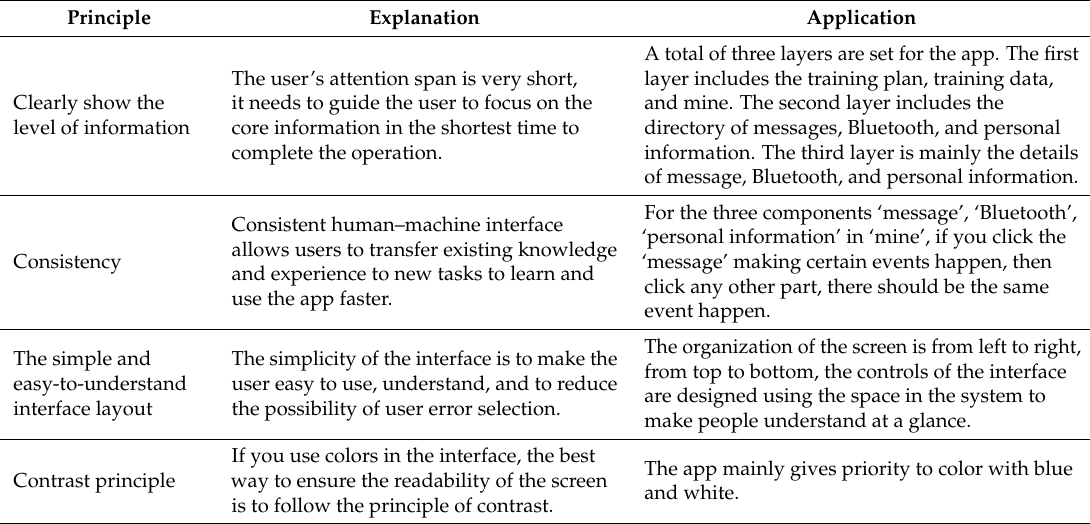
Table 1. The specific application of UI design